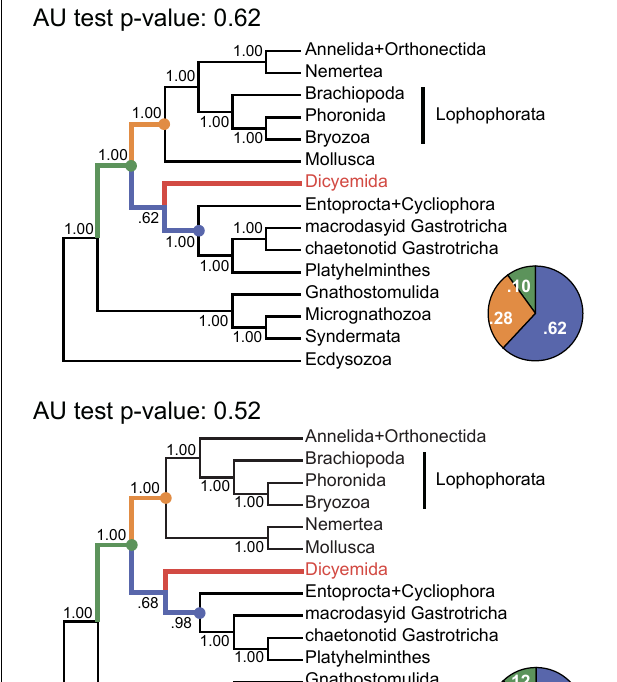
Polyzoa (Entoprocta, Cycliophora, and Bryozoa), and